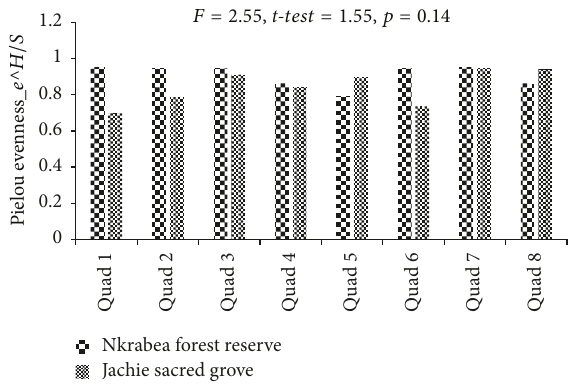
Figure 7: Variations in tree richness in Nkrabea forest reserve and Jackie sacred